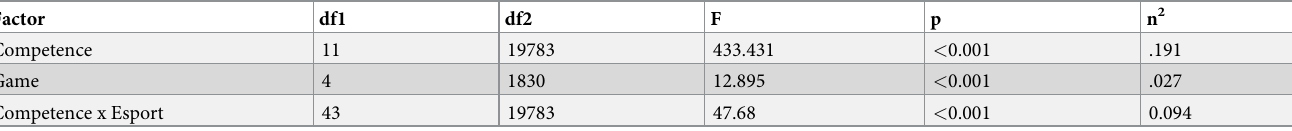
Table 13. Results of the two-factor ANOVA regarding competence fields in different esports.